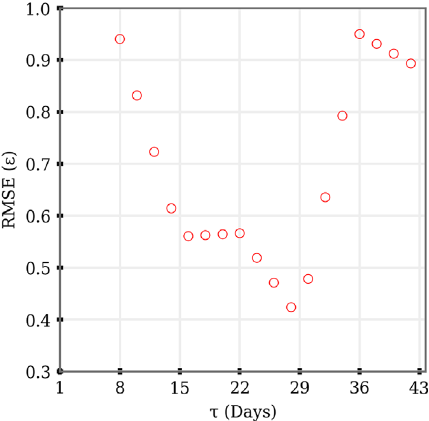
Fig. 6. Variation of root mean square error (RMSE, e ) in with the length of the training window ( s ) in days. Each point of this curve is generated using the average RMSE of two months